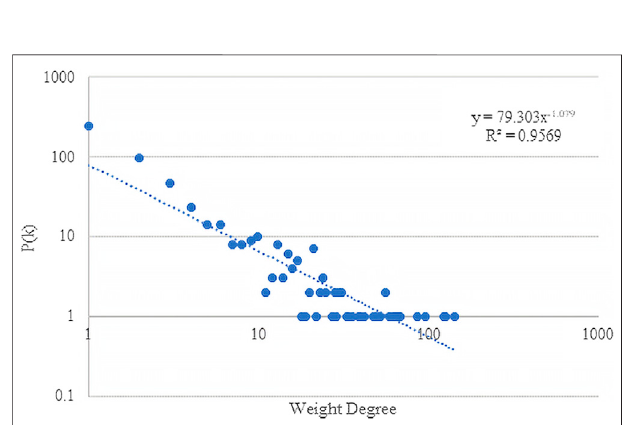
FIGURE 5 | The weight degree distribution of the TOA Network: Plot the number of the weight degree on the vertical Y -axis to logarithmic against weight degree on the horizontal x -axis to